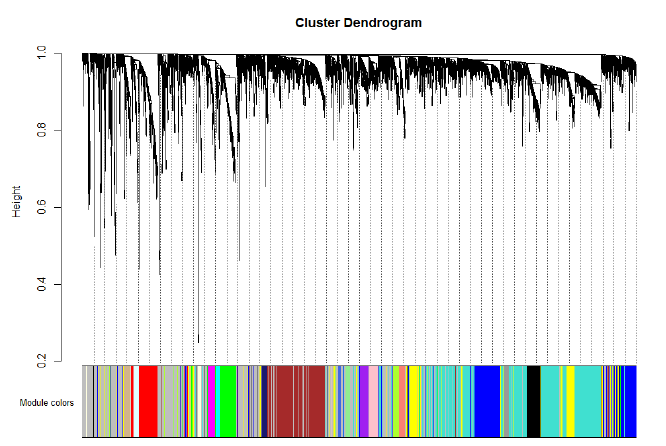
Figure 2. The hierarchical clustering tree of 21 co-expression modules.